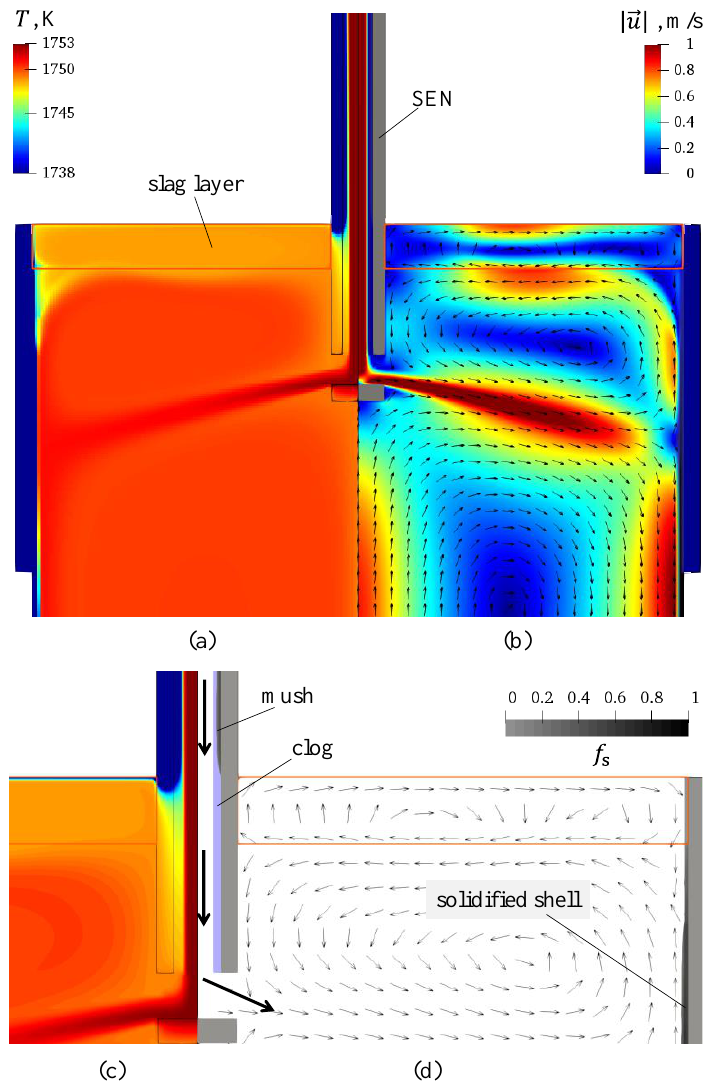
Figure 5. Simulation results overview: ( a ) temperature field; ( b ) velocity magnitude distribution; ( c ) local temperature in the SEN/slag region; ( d ) clogging and melt solidification inside SEN.